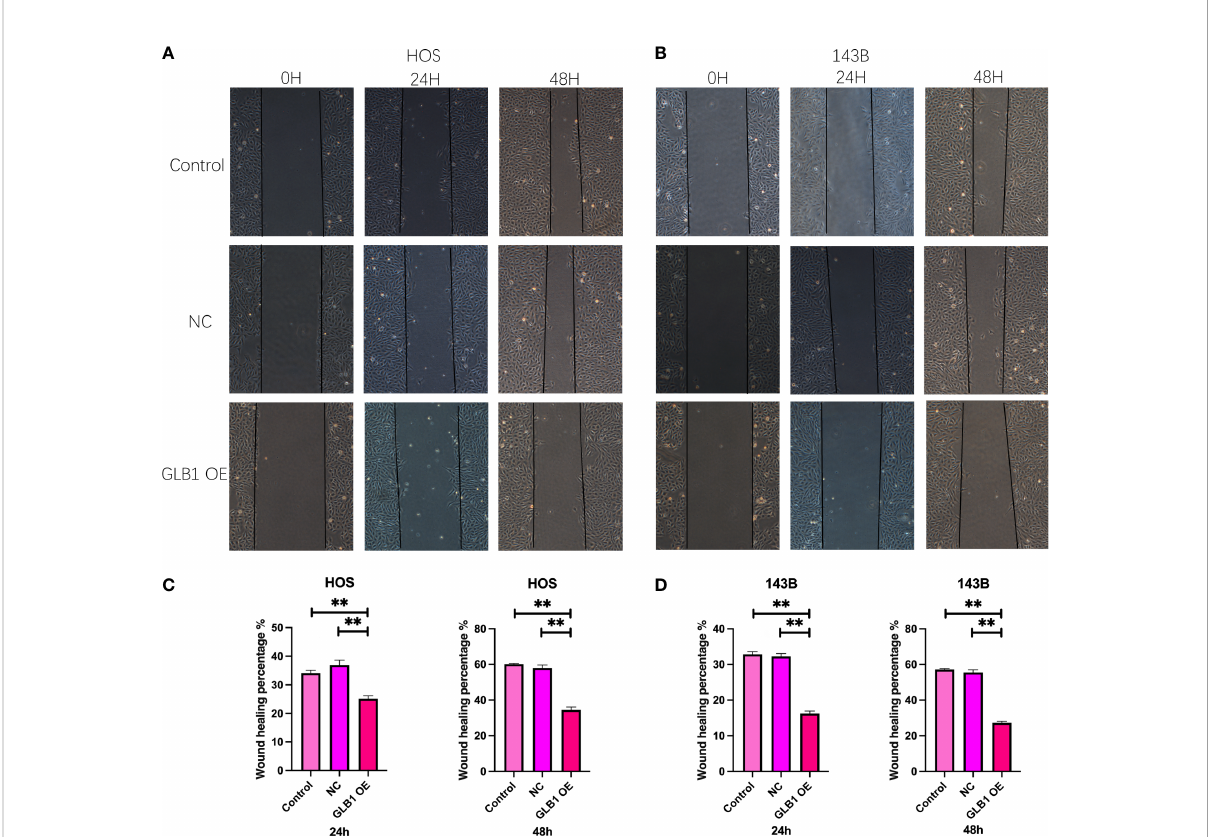
FIGURE 15 Overexpress GLB1 inhibits the migration of human OS cell lines. (A, B) The photograph of wound healing assay at 0h, 24h, 48h. The area is signi fi cantly smaller in GLB1 OE group. (C, D) The statistical analysis results of wound healing assay. All the results revealed that overexpress GLB1 could inhibits the migration of human OS cell lines (HOS, 143B). “ ** ” represented “ p<0.01 ”